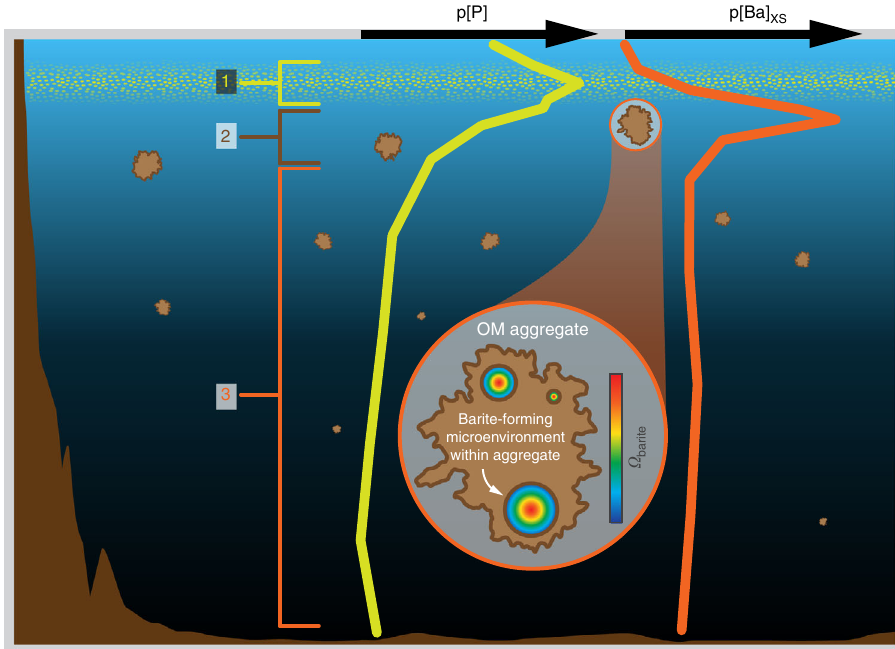
Fig. 4 Conceptual model of barium cycling in low-sulfate water columns. Depth pro fi les of p[P] and p[Ba] XS from St. FWM. (1) Autotrophic production leads to a peak in OM (organic matter) near the surface, indicated by the maximum in p[P]. (2) Microbial respiration within aggregates of decaying OM leads to development of barite-supersaturated microenvironments and precipitation of barite. (3) Continued respiration diminishes OM concentrations and destroys protected microenvironments, preventing further build up of Ba 2+ and sulfate ions and thus any additional barite formation; settling barites are exposed to undersaturated waters and may start to